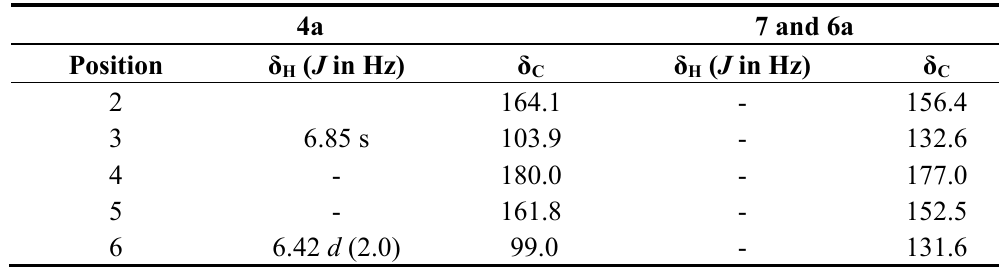
Table 3. 13 C and 1 H-NMR Data ( J in Hz) for the compounds 4a , 7 and 6a (500 MHz, δ ppm, in DMSO- d6